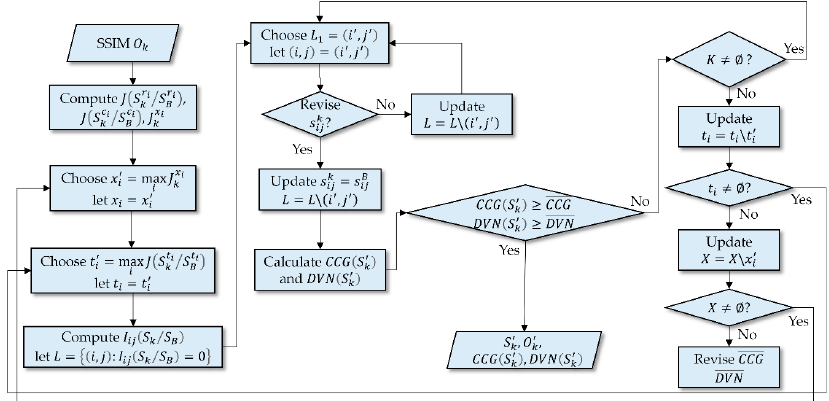
Figure 3. Flow chart of the group consensus improvement algorithm.